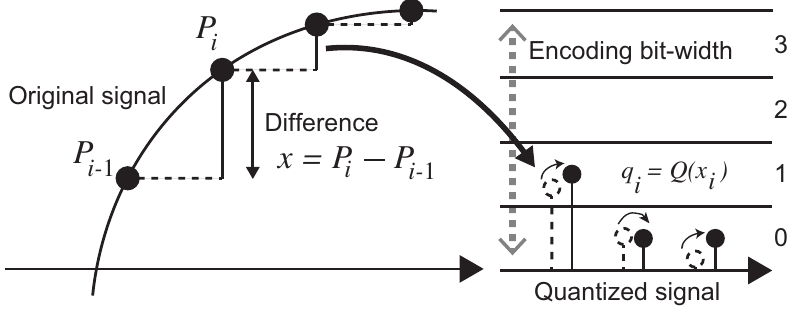
Figure 1. Encoding processes of